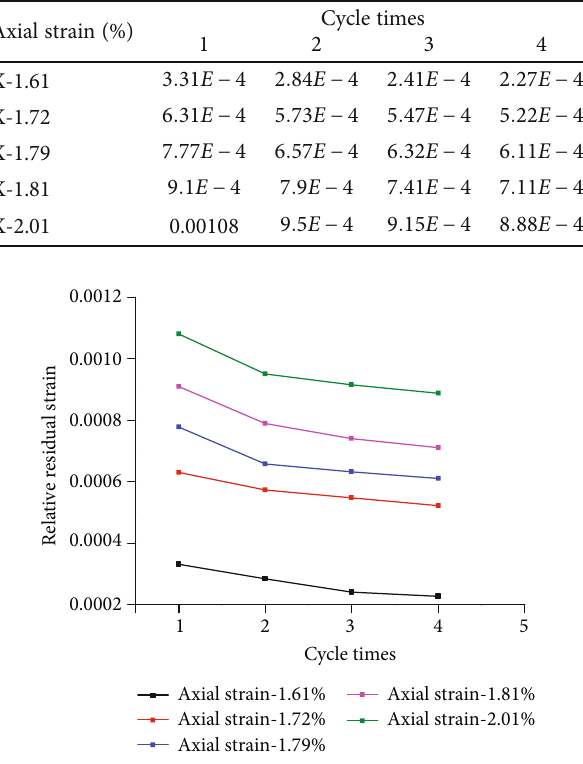
− σ 3 3 curve under